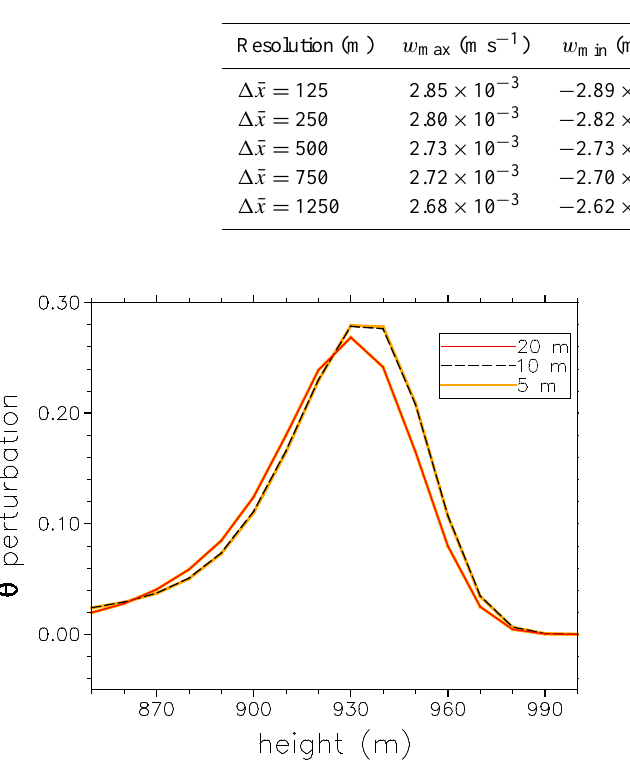
Table 4. Comparison of the numerical results for various horizontal resolutions for the inertia–gravity wave. All simulations use eighth-order polynomials per element and a vertical resolution of (cid:49) ¯ z = 250m.